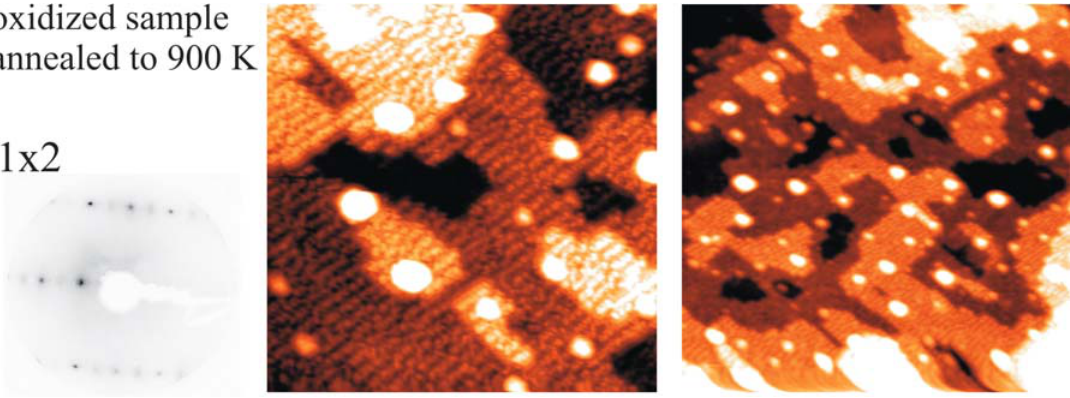
Figure 5 . LEED and STM images of a 1x2 reconstructed surface obtained by vacuum annealing of a thoroughly oxidized SnO (110) sample to ~950 K in vacuum.(reproduced with permission from ref. 2